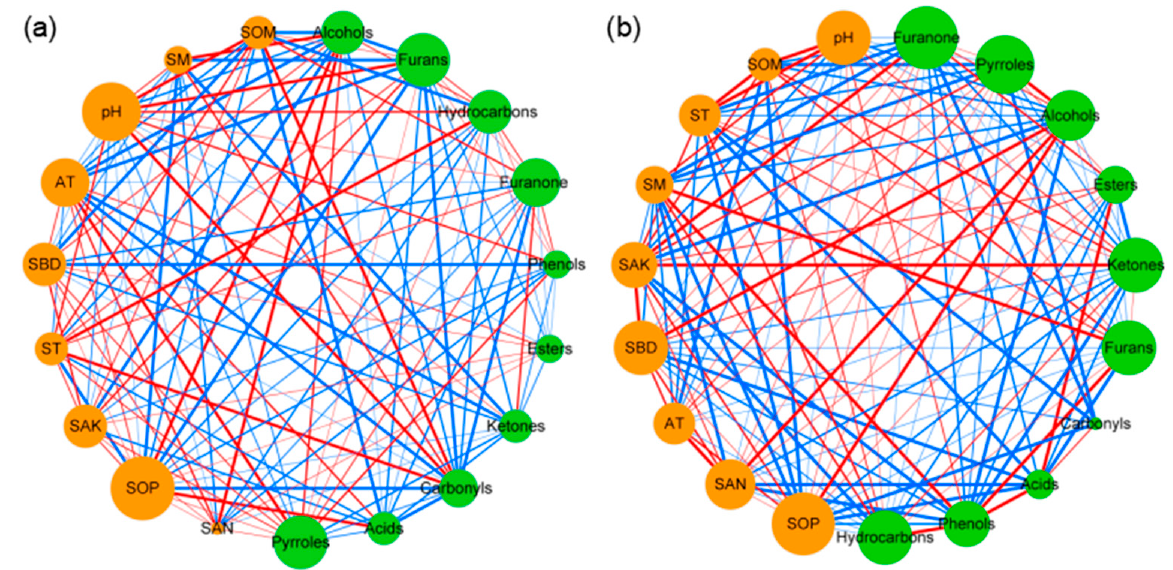
Figure 2. Effects of monoculture and intercropping patterns on the component numbers and relative contents of volatile substances in different categories (PLSDA). See Figure 1 for treatment abbrevi- ations.